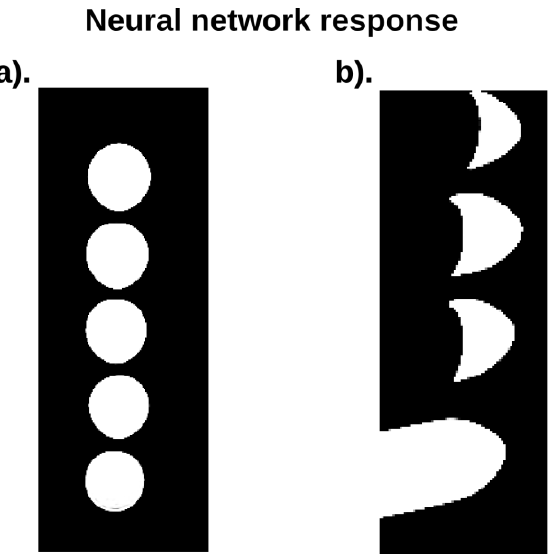
Figure 7. ( a ) presents the “response” of the neural network that was obtained as a result of the analysis of DICOM image sets for the T 1 longitudinal relaxation time in phantom consisting of 5 test tubes; ( b ) presents the “response” of the neural network that was obtained as a result of the analysis of DICOM image sets for the T 1 longitudinal relaxation time in MCF-7 cell culture. The task of the neural network was to classify the data into two categories. The first is the category of the area whose MR characteristics correspond to the resonance characteristics of magnetic resonance phenomena–white area, while the second is the area whose behavior does not correspond to MR phenomena–black area. On the basis of this answer, the aerated areas were not analyzed, which allowed to reduce the time needed for data processing and thus to optimize it.